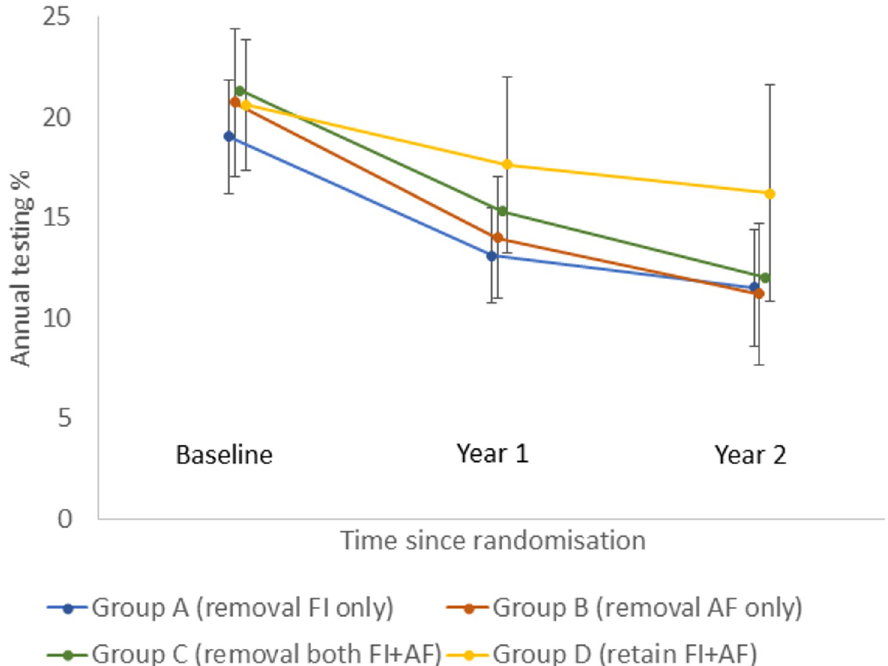
Fig 4. Proportion of patients tested for chlamydia per year by time since randomisation: Intervention group analysis. Error bars correspond to 95% confidence intervals. AF, audit/feedback; FI, financial incentives.